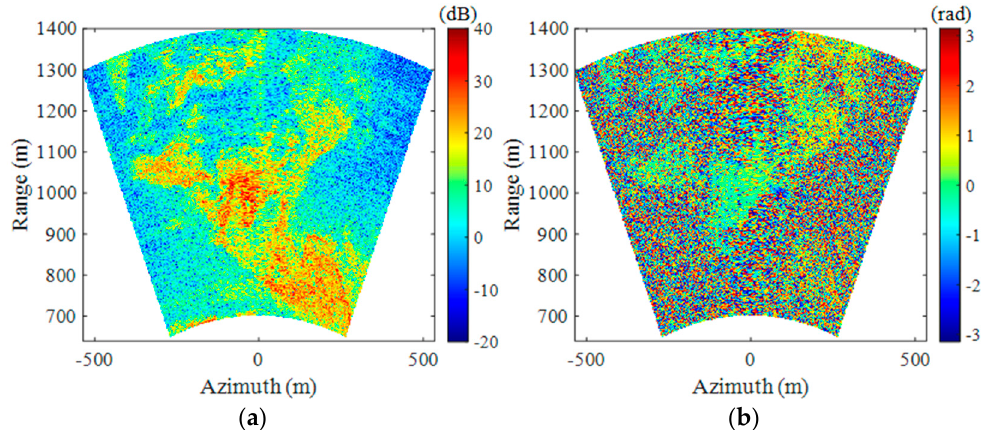
Figure 4. ( a ) Power image of the monitoring area; ( b ) phase interferogram. Not all pixels in a GB-InSAR interferogram are suitable for phase analysis. To guar- antee measurement accuracy, only pixels with high phase quality are processed. The ADI (amplitude dispersion index) method is commonly utilized to select appropriate pixels, also known as permanent scatterers (PSs). A pixel’s ADI is defined as the ratio between the standard deviation and mean value of its time-series amplitudes. A smaller ADI means a higher phase stability. Figure 5a shows the ADI map calculated with the first 30 radar images. By setting an ADI threshold of 0.35 and an SNR threshold of 10 dB, sufficient PSs were selected. Figure 5b shows the PS phase map. Notably, almost all the PSs are located on the bare slopes.